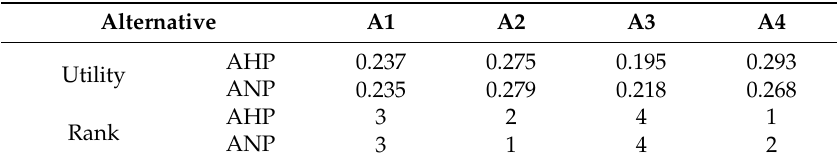
Table 9. Utility and rank of